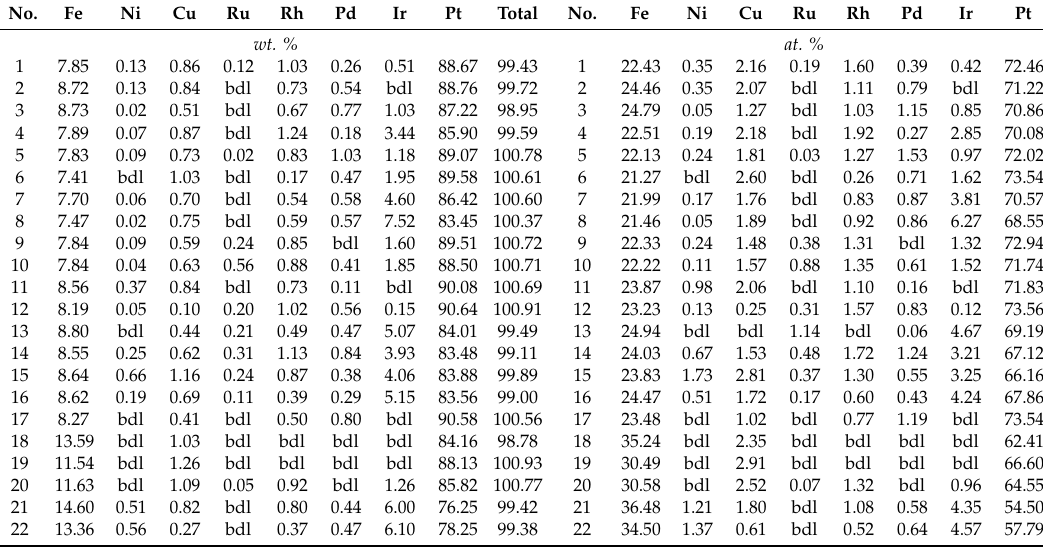
Compositions of isoferroplatinum (1–20) and ferroan platinum (18–22) from the chromite-platinum ore zones of the Svetloborsky massif and associated placers.